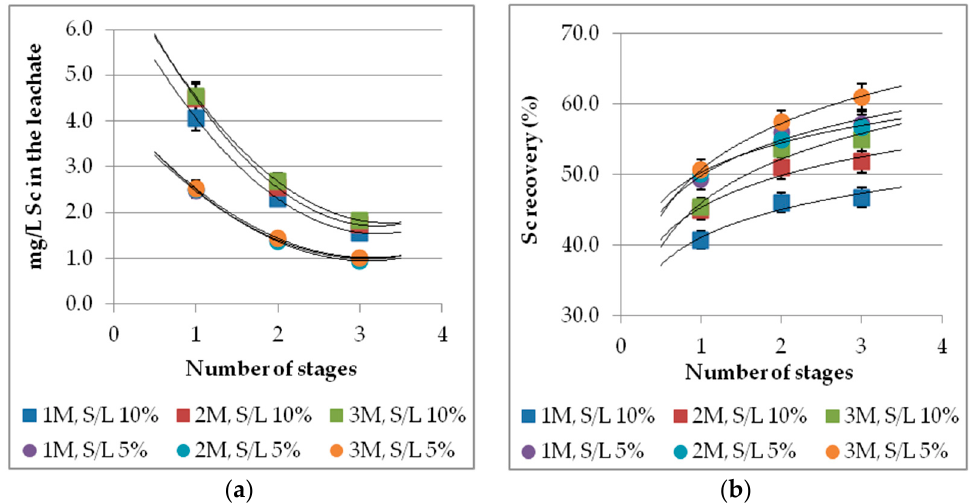
Figure 7. Multistage effect on: ( a ) Sc concentration; ( b ) Sc recovery (%) for different acid molarities and S/L values ( t = 60 min, ambient conditions).